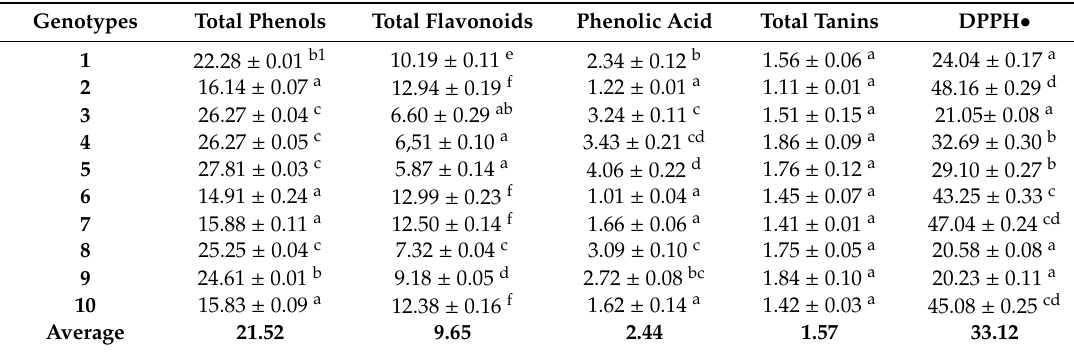
Table 2. Concentration of polyphenols (mg · g − 1 DW) in leaves of Stevia rebaudiana genotypes. Genotypes